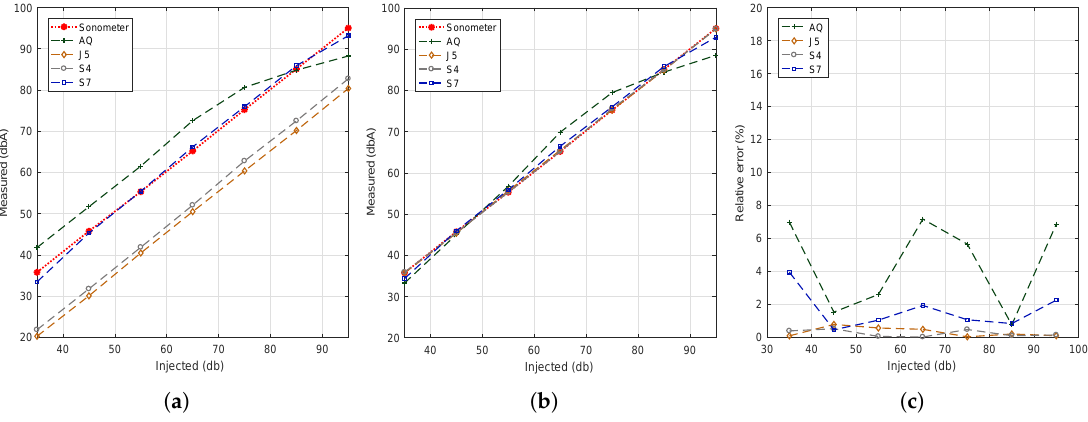
Figure 9. Estimation accuracy for the different smartphone models with and without linear regression. ( a ) default sampling; ( b ) values adjusted using linear regression; ( c ) estimation